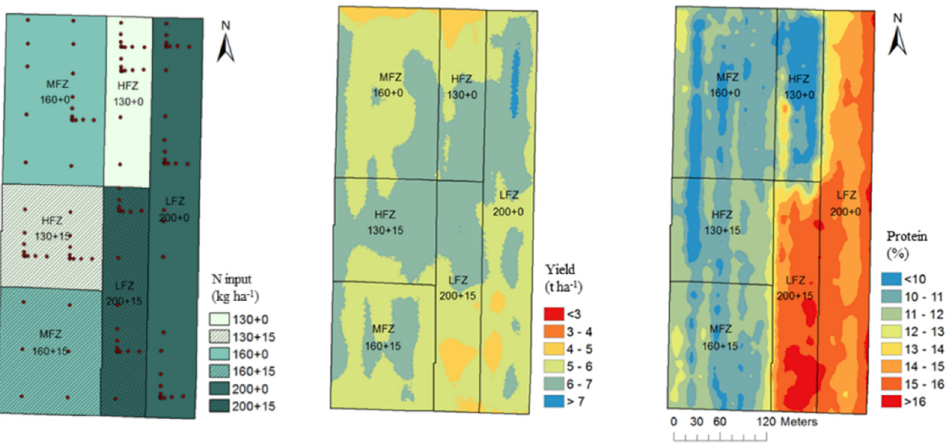
Figure 1. Map of the different fertility zones (left), yield (ha; center), and protein content (%, right)